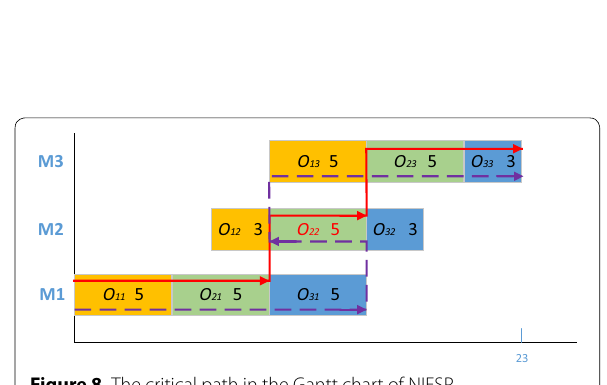
Figure 8 The critical path in the Gantt chart of